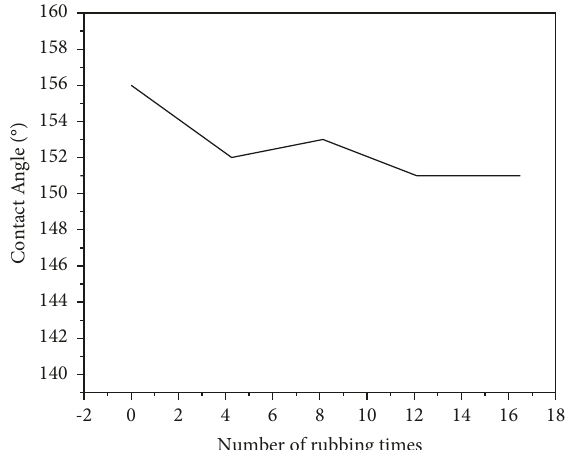
Figure 7: The contact angle of the surface of the square column varies with the number of frictions.